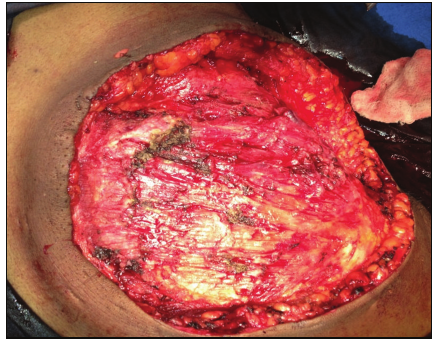
Figure 4: Chest wall after excision.